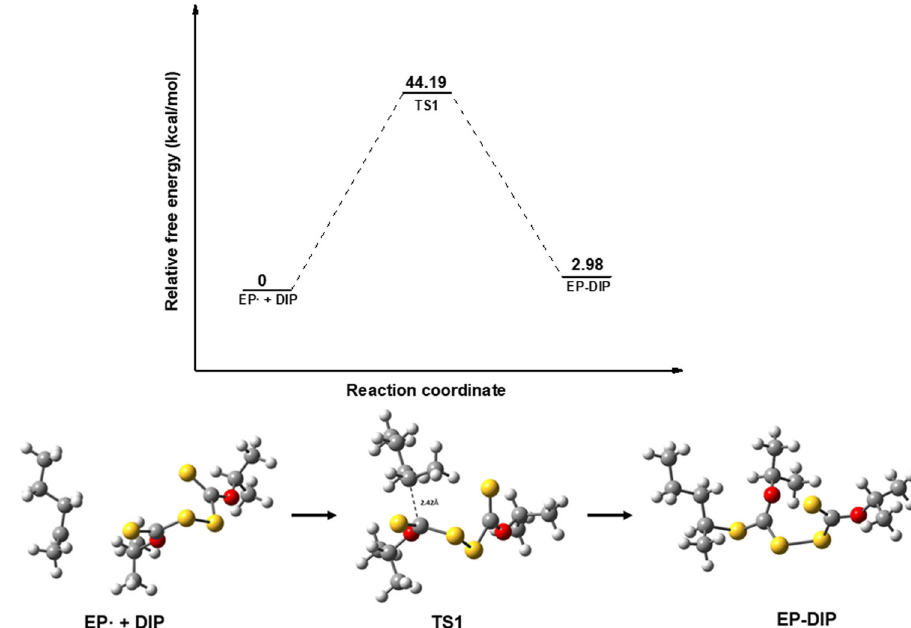
Fig. 10 Energy pro fi les and reaction process. The addition reaction of the fi rst proposed pathway.